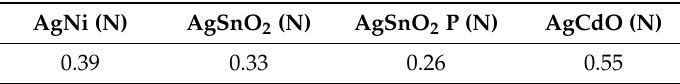
Table 2. Contact force for di ff erent contact